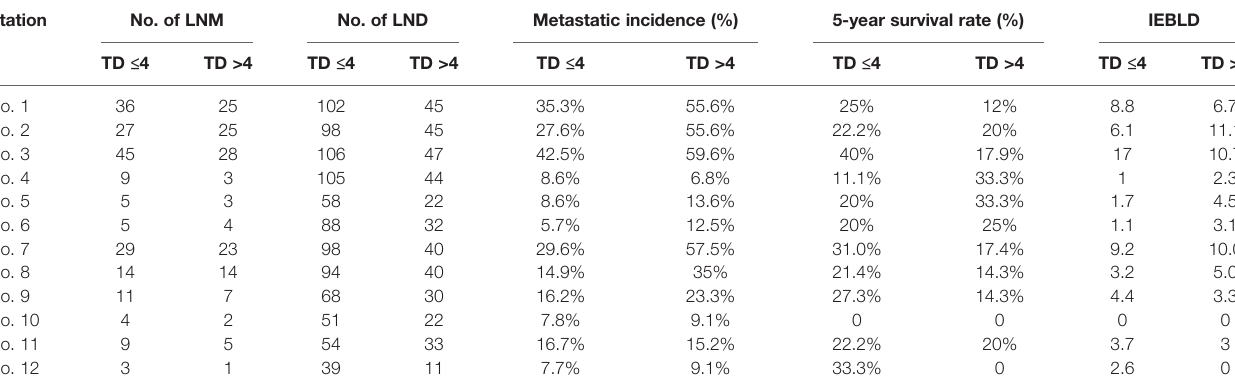
TABLE 4 | Therapeutic value index of each lymph node station in Siewert type II AEGs based on tumor diameter. Station No. of